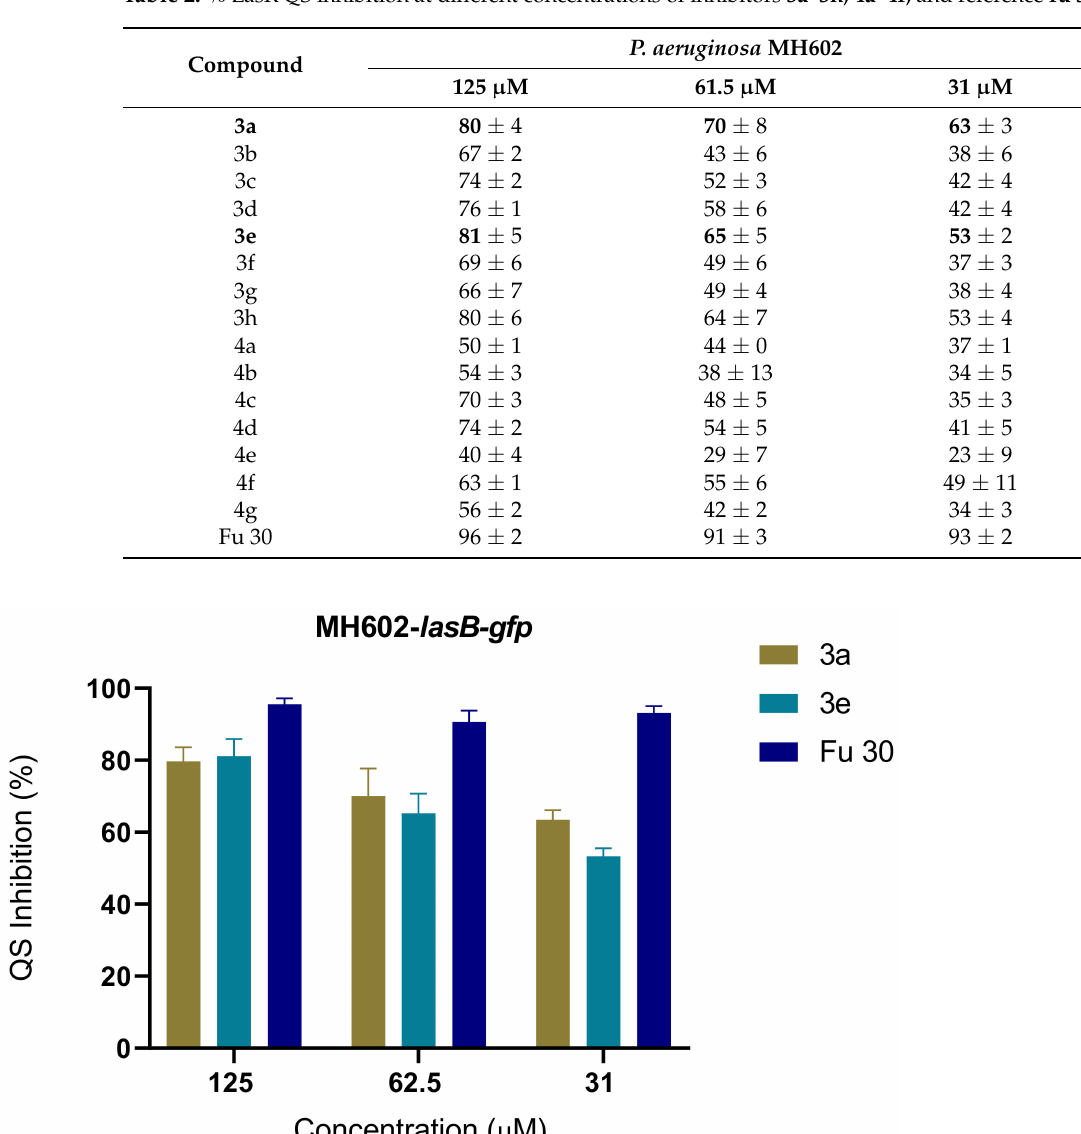
Table 2. % LasR QS inhibition at different concentrations of inhibitors 3a–3h , 4a–4f , and reference fu 30 .